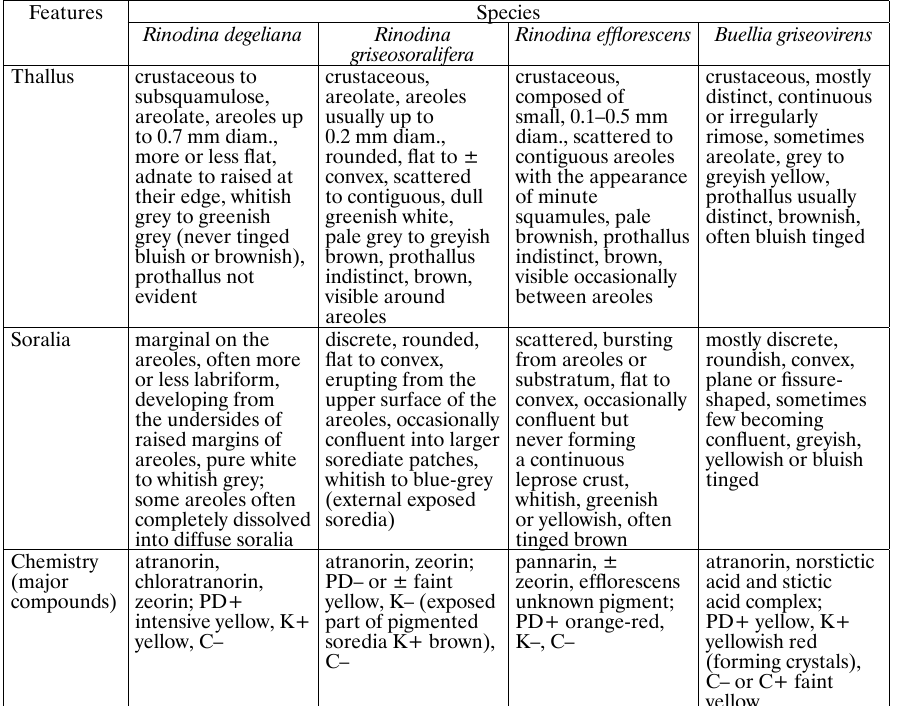
Distinguishing features between Rinodina degeliana and superficially similar species (acc. to various